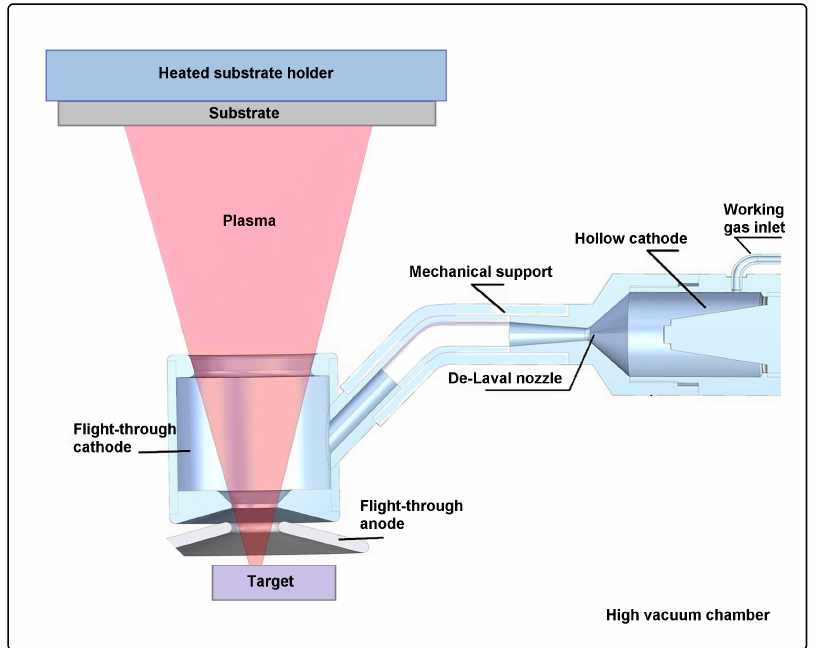
Figure 1. Scheme of the IJD deposition system JetDep100 used in preparation of the studied samples; the main construction parts are indicated (see text for details).